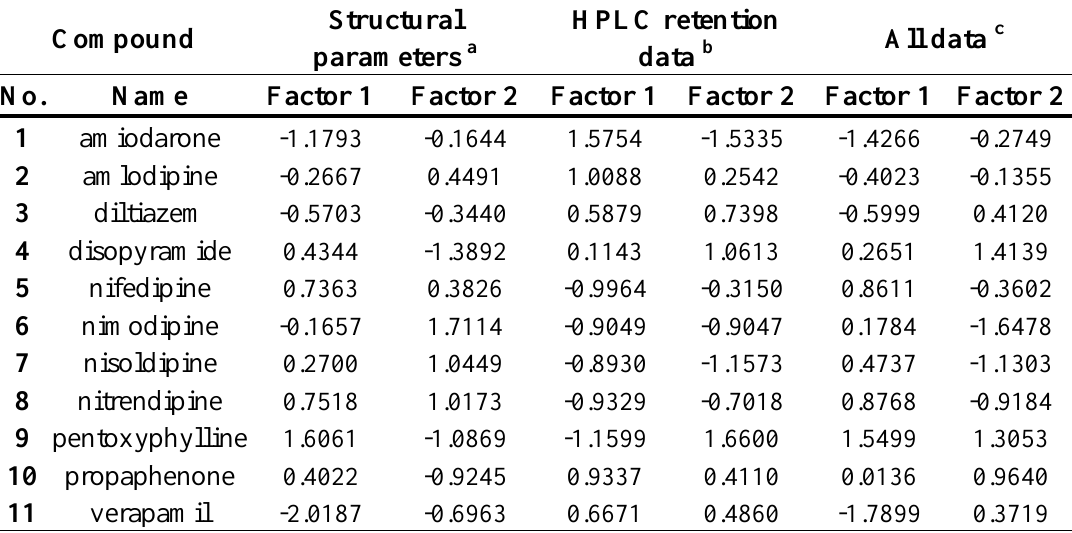
Table 7. Principal component analysis scores of the studied